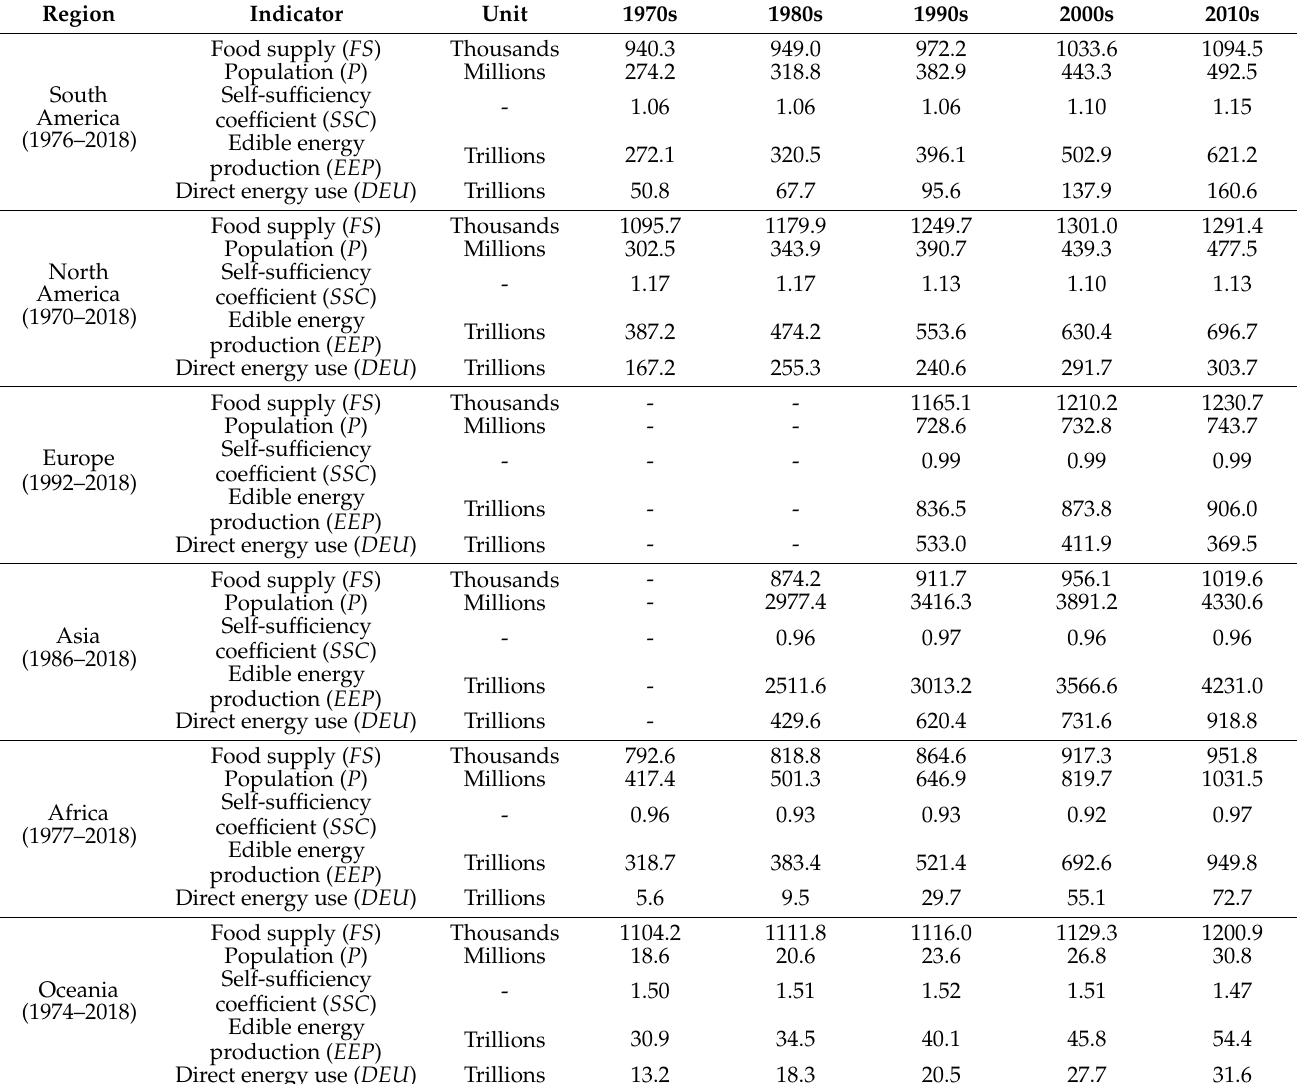
Table A2. Detailed average results used during the EROI calculations for years